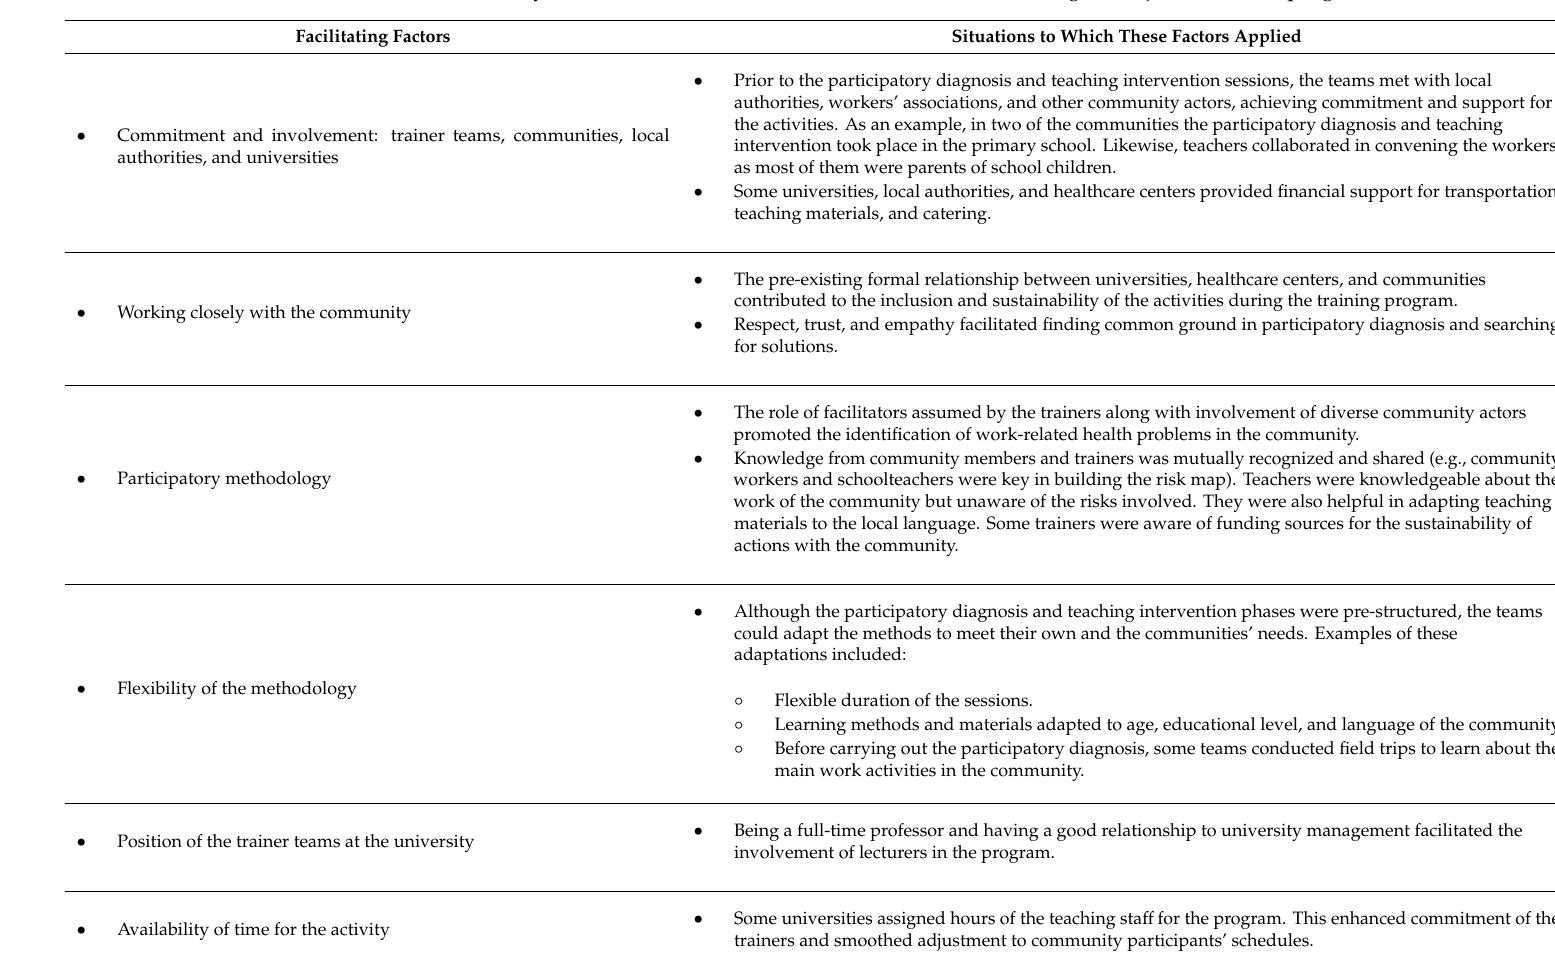
Table 3. Factors identified by the trainers as facilitators and hinderers for achieving the objectives of the program. Facilitating Factors Situations to Which These Factors